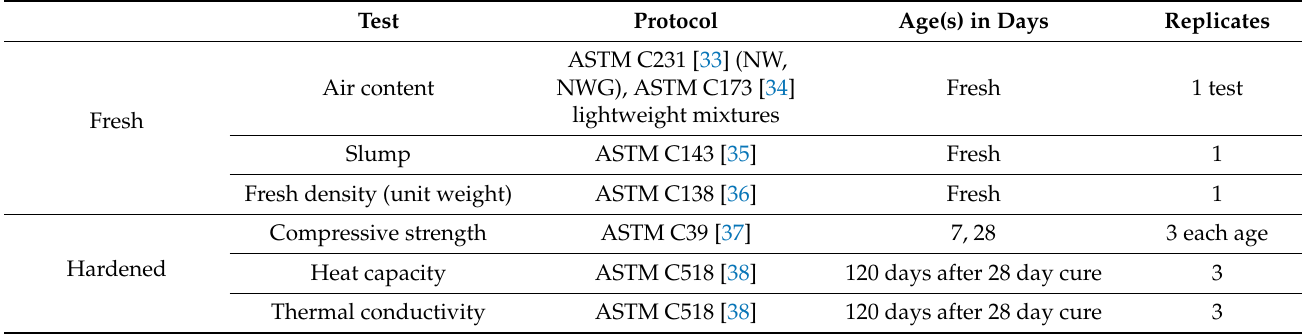
Table 3. Laboratory testing